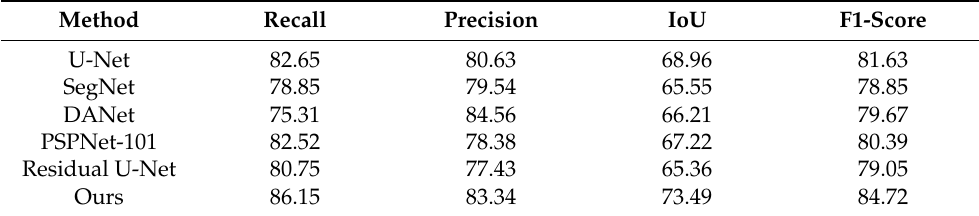
Table 7. Quantitative comparison results (%) among our method and the other five classical building extraction and segmentation methods tested on the Massachusetts Building dataset.